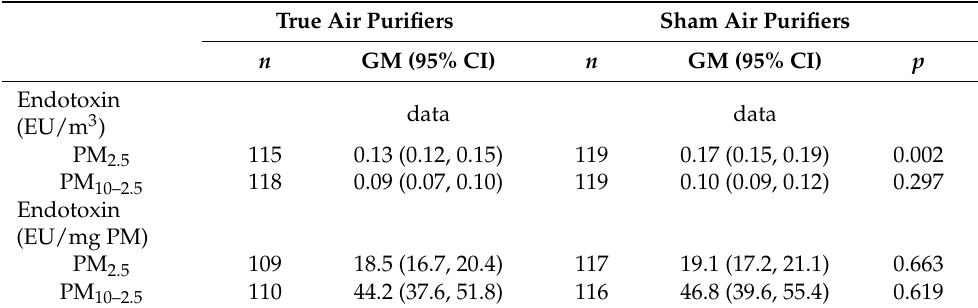
Table 2. Comparison of measurement results of each concentration using the true and sham air